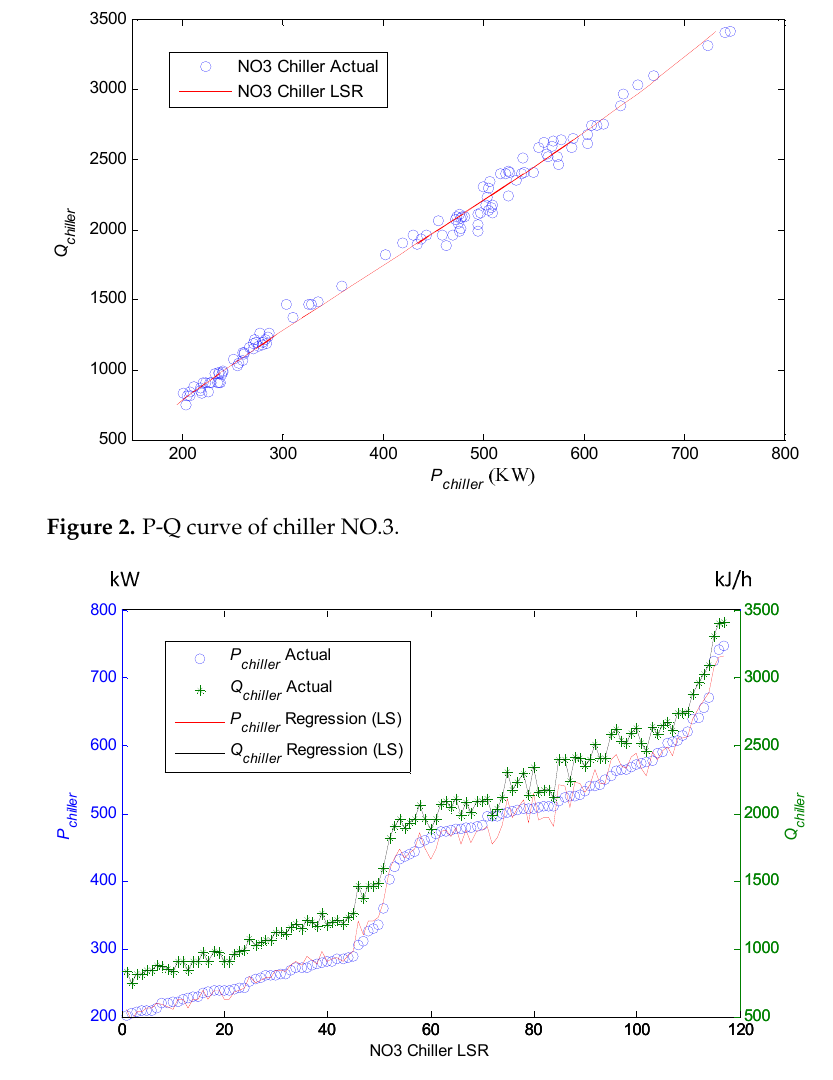
Figure 3. Chiller NO.3 in the LSR model. Table 1. Chillers NO.1-NO.6 and the ice storage LSR.